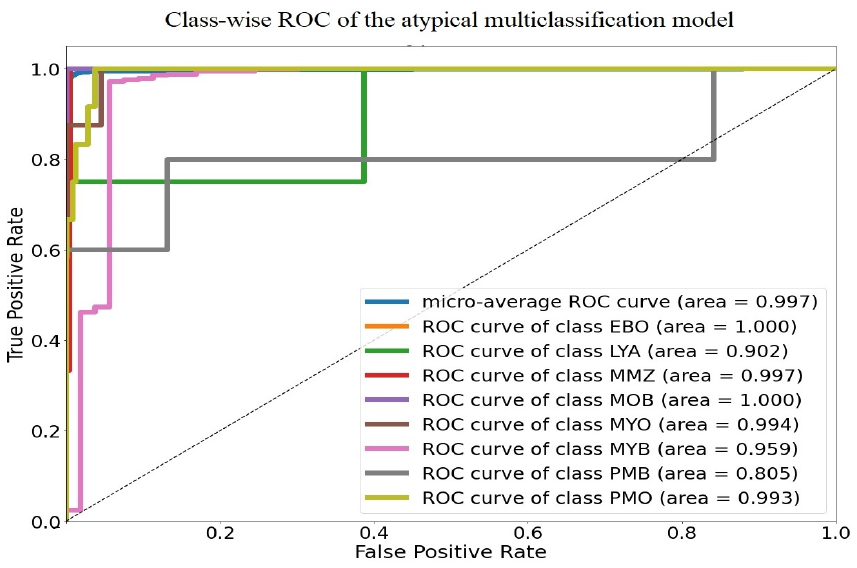
Figure 14. ROC curve for Stage II: DCAE-CNN